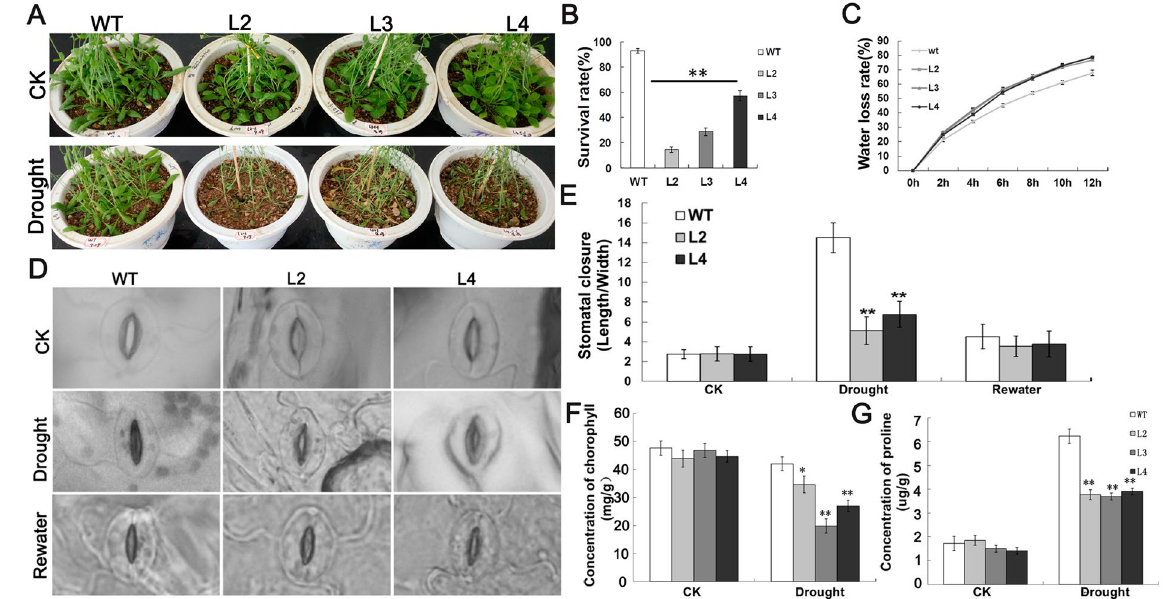
Figure 6. Assay of GhWRKY33 overexpression transgenic Arabidopsis tolerant to drought stress. ( A ) phenotypic analysis of 3-week-old wild type and GhWRKY33 transgenic Arabidopsis grown in soil under normal conditions (top) or drought stress by withholding water for 10 days (bottom). ( B ) Survival rates of the plants shown in (A) after re-watering. ( C ) Water loss rate of the detached leaves of GhWRKY33 overexpression transgenic lines and wild type. ( D ) Stomatal closure of transgenic lines and wild type with or without drought stress were observed. ( E ) Measurement and statistical analysis of stomatal closure (stomatal length:width ratio) under drought treatment (n > 40 for each sample). ( F ) Assay of chlorophyll content in leaves of GhWRKY33 overexpression transgenic lines and wild type under normal conditions and under drought stress. ( G ) Assay of proline accumulation in leaves of GhWRKY33 overexpression transgenic lines and wild type under normal conditions and under drought treatment. Mean values and standard errors (bars) are shown from three independent experiments. One and two asterisks represent there was a significant difference (P < 0.05) and a very significant difference (P < 0.01) in Duncan’s multiple range test, respectively. CK, seedlings grew in soil under normal conditions as controls; Drought, seedlings grew in soil kept from water (under drought stress); WT, wild type; L2, L3 and L4, three GhWRKY33 overexpression transgenic